Question: In one sentence, what is this figure communicating?
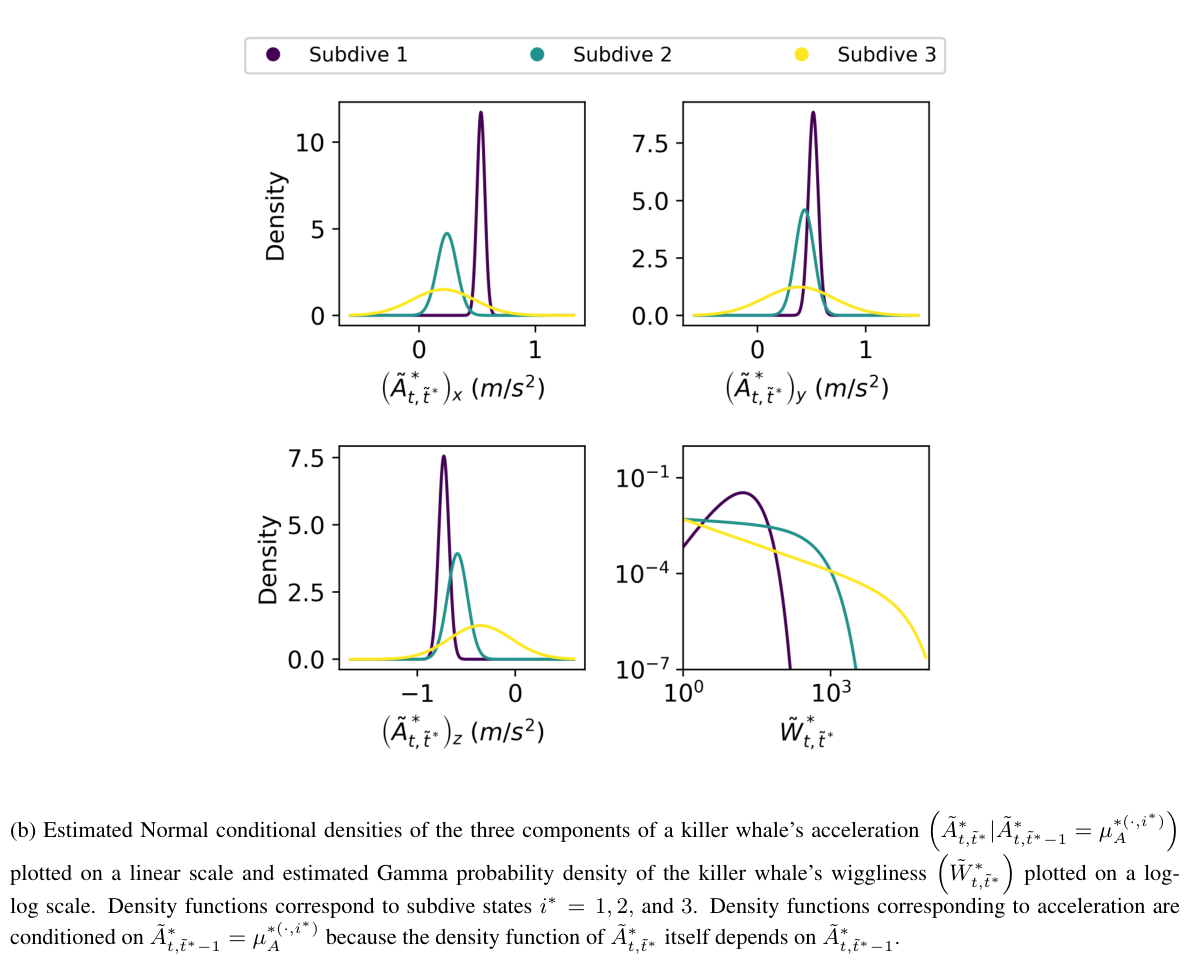
Answer: Estimated probability density functions for coarse-scale and ﬁne-scale emissions corresponding to obser- vations of killer whale behaviour. Densities are estimated by ﬁtting the CarHHMM-DFT to the case study data (see Table 1).